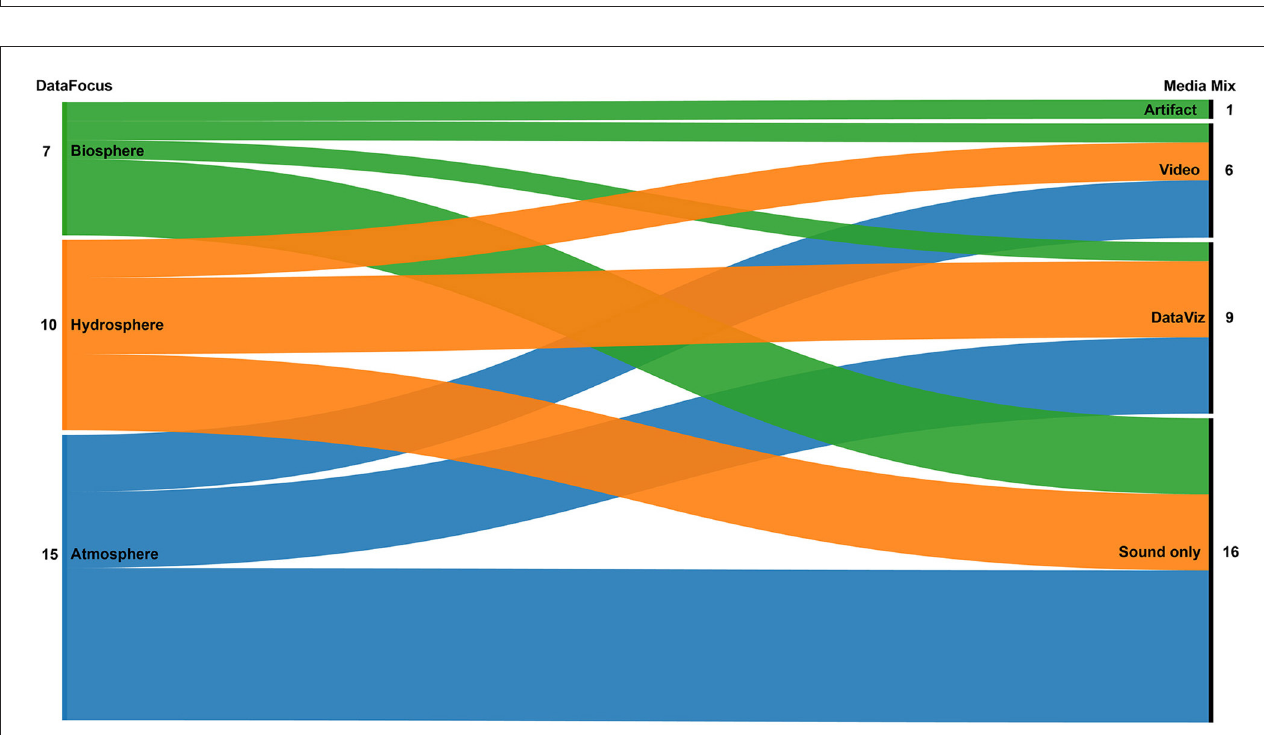
FIGURE7 Correlation between the three data foci (atmosphere, biosphere, and hydrosphere) and the mix of media used in the selected projects.